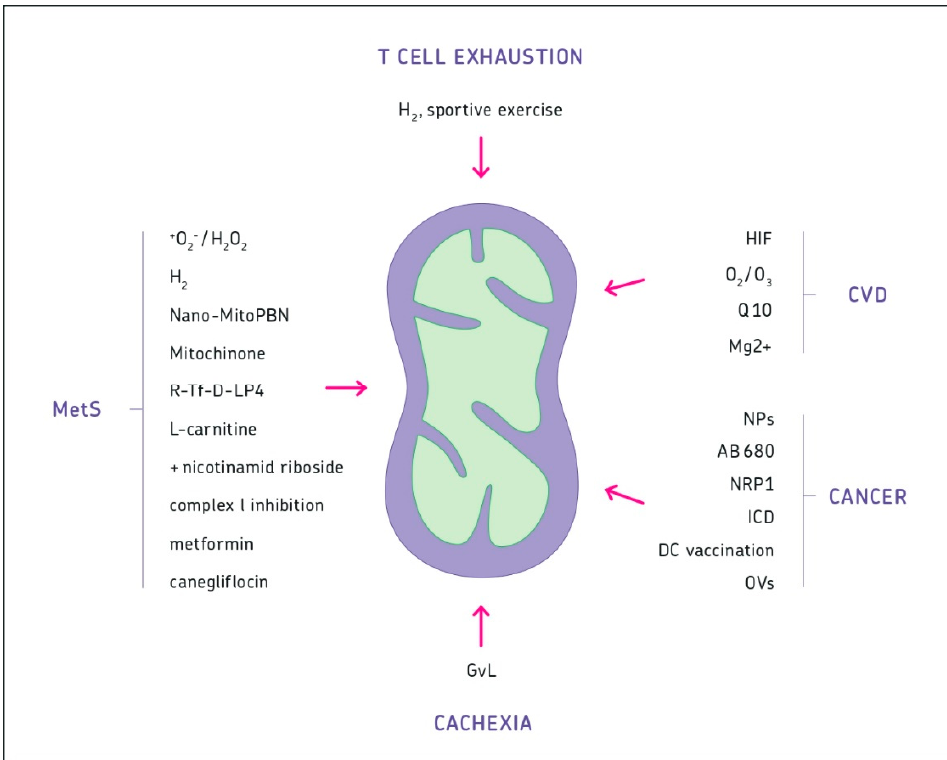
Figure 1. Mitochondria-targeted interventional strategies with metabolic syndromes (MetS), cardiovascular diseases (CVD), cancer (with tumor microenvironment), cancer cachexia, and T cell exhaustion. All interventional strategies are dealt with in the main text. H 2 = molecular hydrogen; NPs = nanoparticles; ICD = Immunogenic cell death; DC vaccination = vaccination with dendritic cells expressing tumor antigens and eliciting immunological danger signals; GvL = Graft-versus-Leukemia effect exerted by immune T cells; OVs = oncolytic viruses.